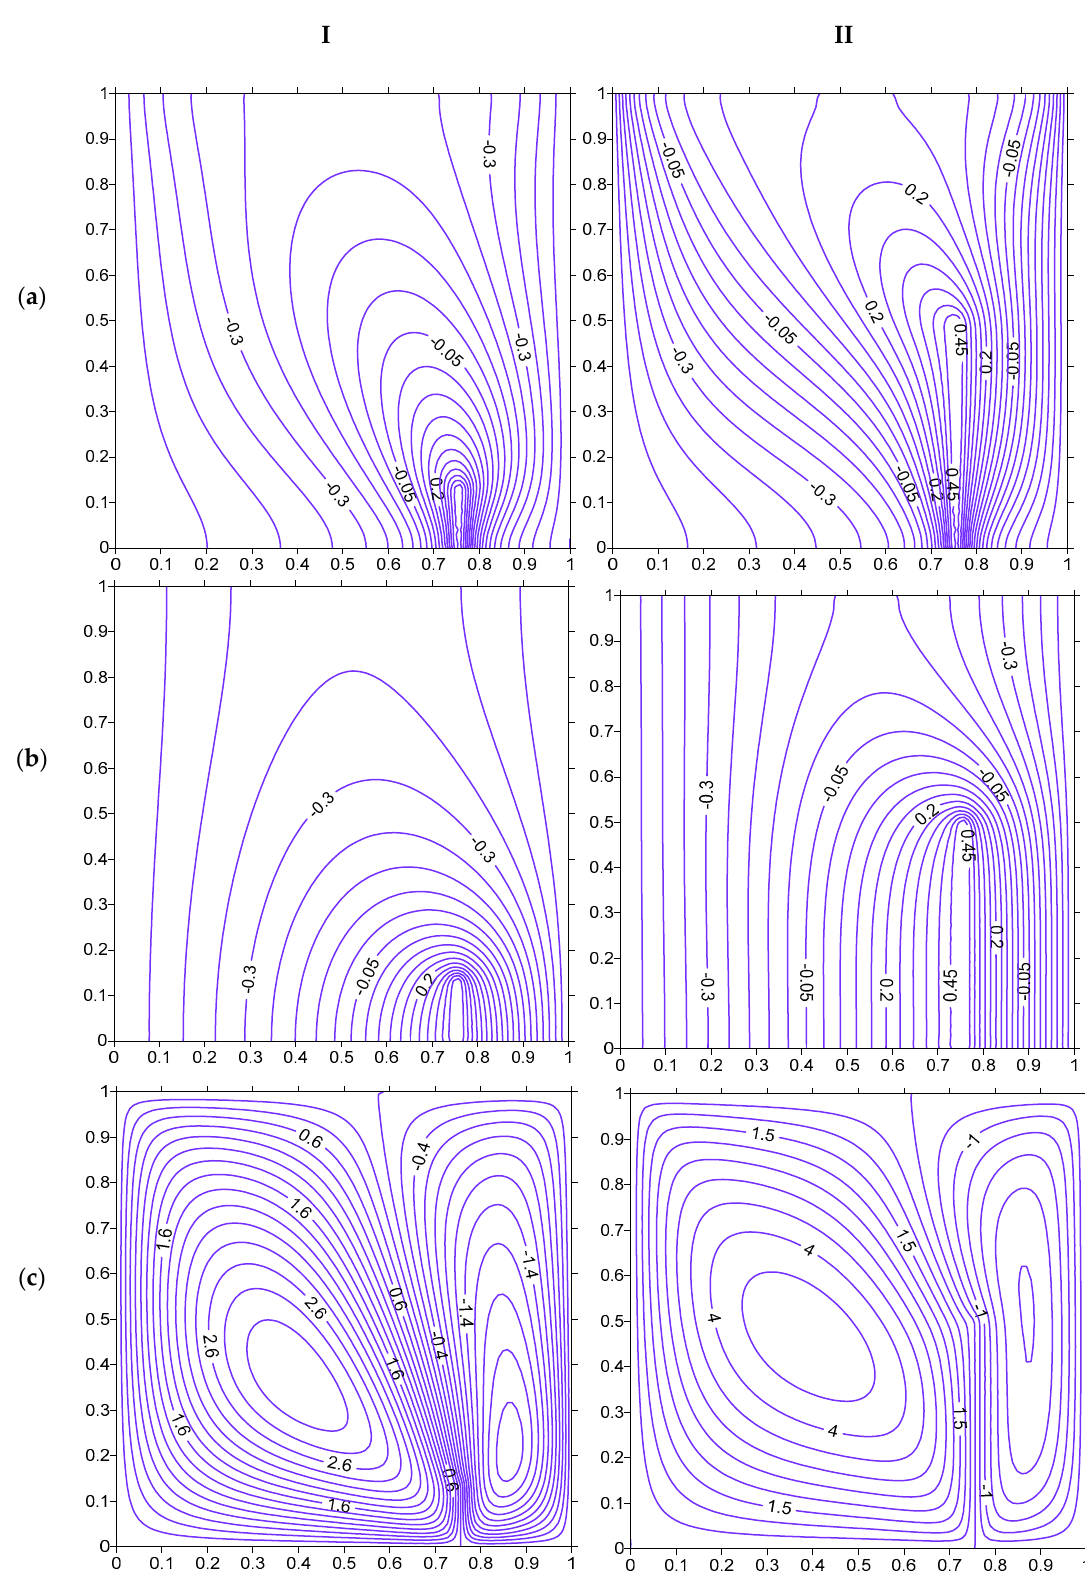
Figure 9. Isotherms (( a ) Fluid, ( b ) Solid), and streamlines ( c ), at Ra = 100, H = 5, Kr = 1, Rd = 0 for strip at x = 0.75. ( I ) HH = 12.5%. ( II ) HH =